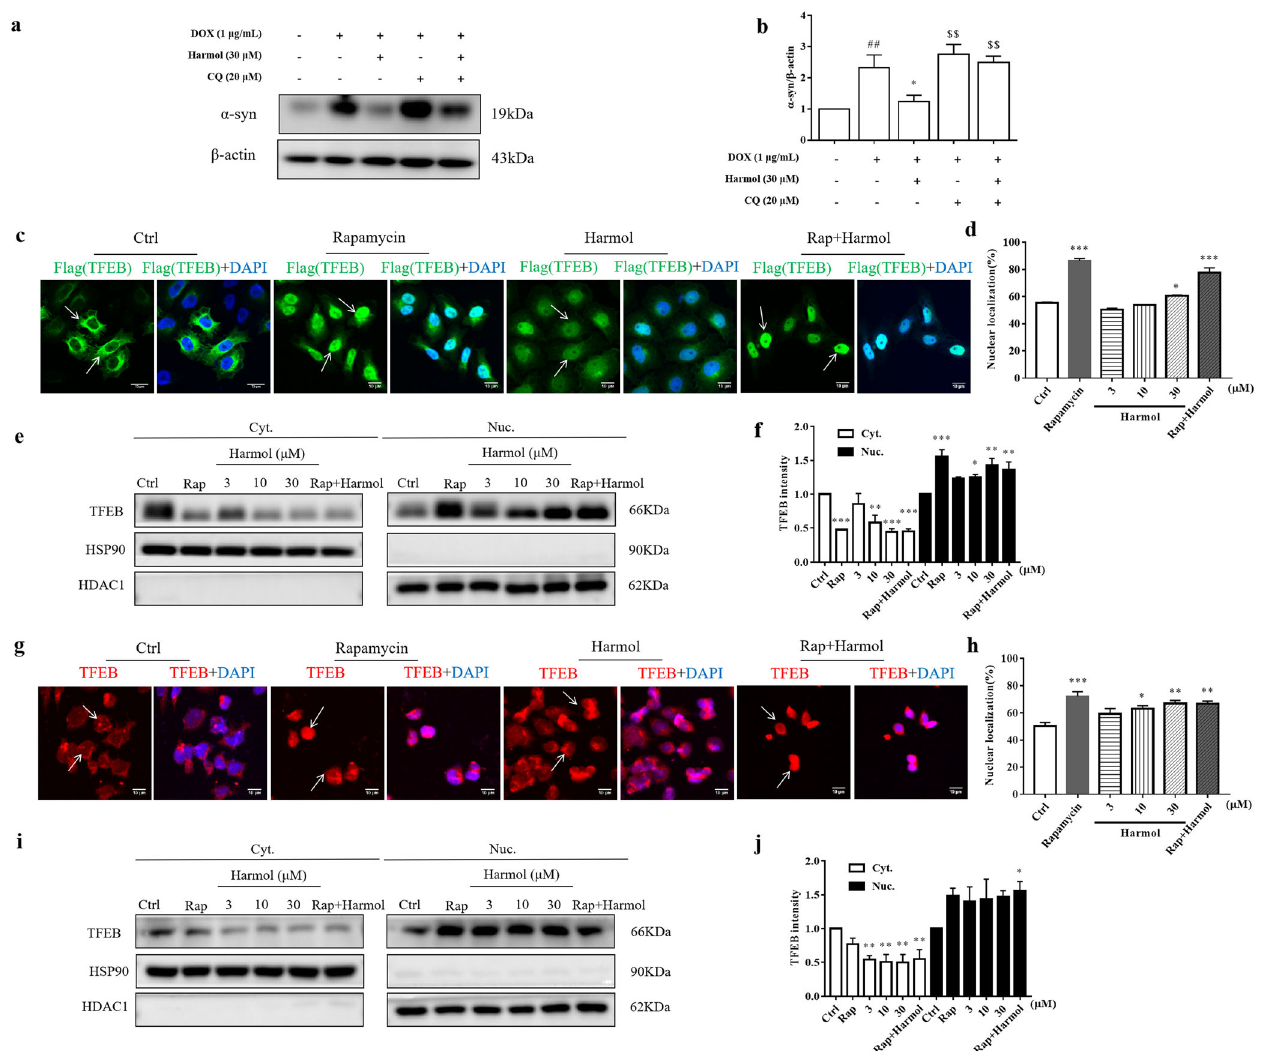
Fig. 2 Harmol promotes the degradation of α -syn through the autophagy-lysosome pathway and the nuclear translocation of TFEB. a Cells were treated with harmol in the presence or absence of CQ (20 µM) for 24 h. The expression of α -syn was determined by western blot. b Data are presented as the mean ± SEM from three independent experiments. ## P < 0.01 vs. the control (0.1% DMSO). * P < 0.05 vs. the DOX. $$ P < 0.01 vs. the DOX + harmol. c HeLa cells stably expressing 3xFlag-TFEB were treated with harmol (30 µM), rapamycin (Rap, 0.25 µM), and the combined administration of harmol (30 µM) and rapamycin (0.25 µM) for 24 h. Cells were fi xed and stained with anti-Flag M2 (green) and DAPI (blue). d Data are presented as the mean ± SEM from three independent experiments. * P < 0.05 and *** P < 0.001 vs. the control (0.1% DMSO). e The levels of 3xFlag-TFEB in the cytosolic (Cyt.) and nuclear (Nuc.) fractions were determined by western blot. f Data are presented as the mean ± SEM from three independent experiments. * P < 0.05, ** P < 0.01 and *** P < 0.001 vs. the control (0.1% DMSO). g N2a cells were treated with harmol then fi xed and stained with TFEB antibody (bred) and DAPI (blue). h Data are presented as the mean ± SEM from three independent experiments. * P < 0.05, ** P < 0.01 and *** P < 0.001 vs. the control (0.1% DMSO). i The levels of endogenous TFEB in the